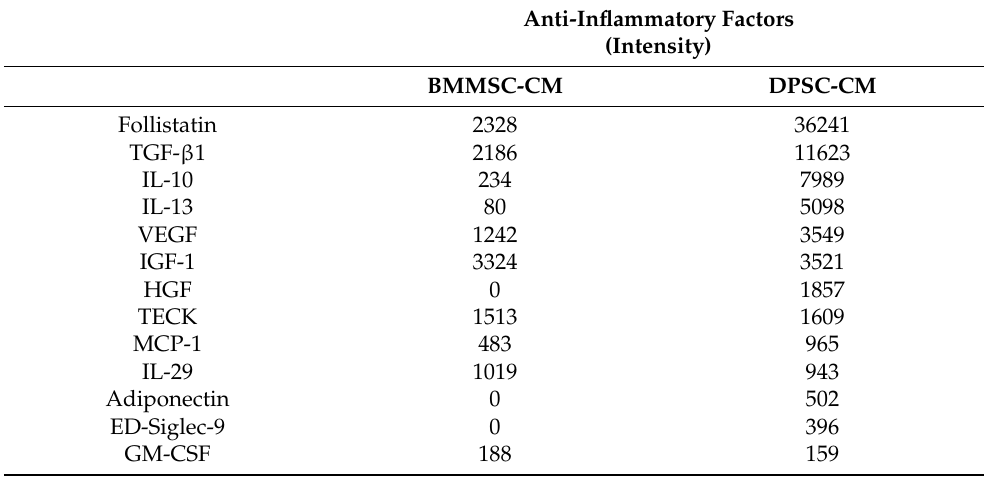
Table 1. The anti-inflammatory factors or DPSC-CM only detected factors of DPSC-CM vs.